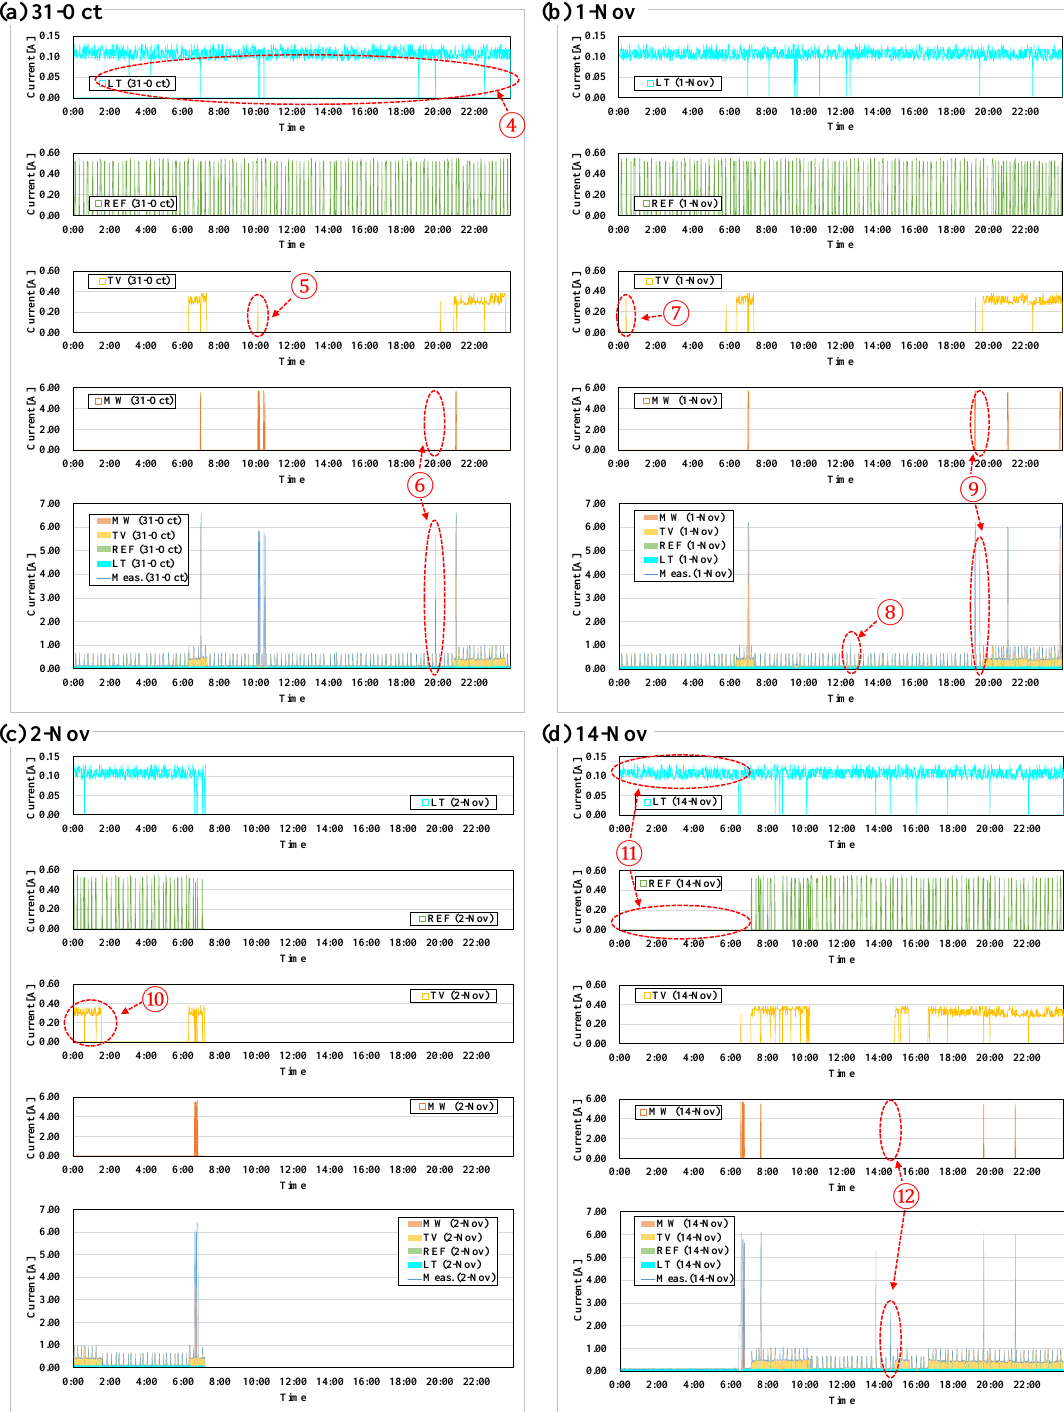
Figure 8. Load disaggregation outcomes for predicted data by date: ( a ) 31 October; ( b ) 1 November; ( c ) 2 November; ( d ) 14 November.